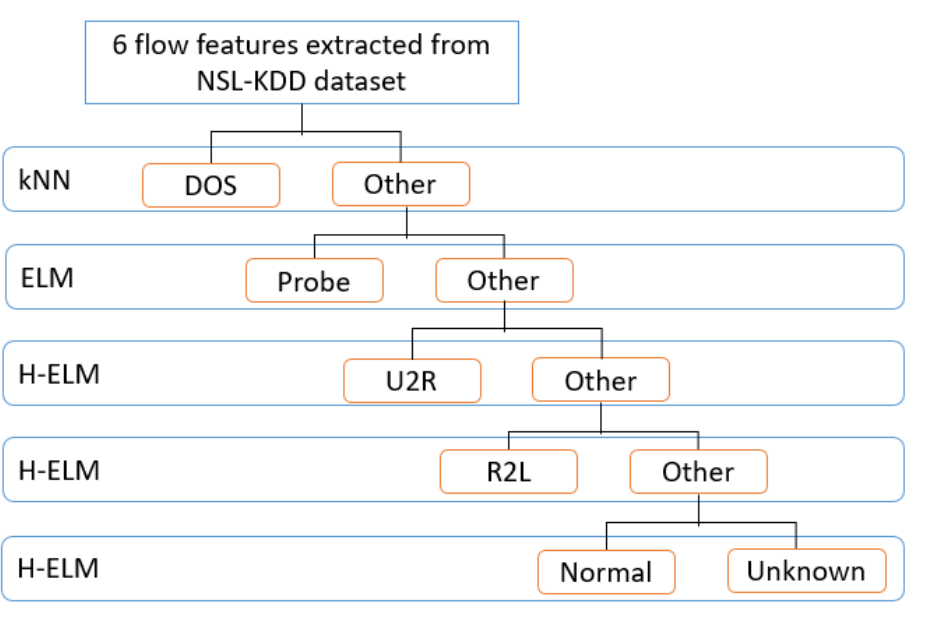
Figure 3. Multi-level hybrid IDS.